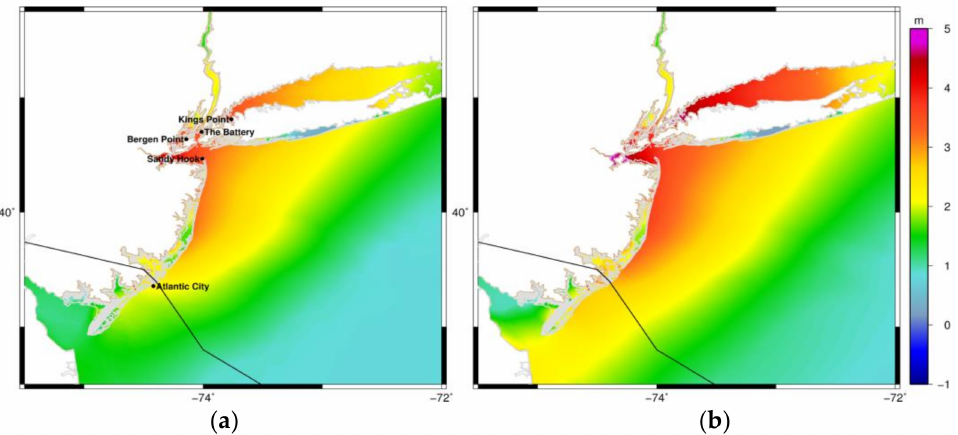
Figure 7. ( a ) Simulated maximum water levels above mean sea level (MSL) during the period of 23 October 0000 UTC through 30 October 1200 UTC for the CTL ADCIRC run forced with the NHC best track dataset. ( b ) Same as ( a ) except simulation is initialized on 28 October 0000 UTC to correspond with initialization period of WRF simulations. The black line indicates the track of Hurricane Sandy as it made landfall in New Jersey north of Atlantic